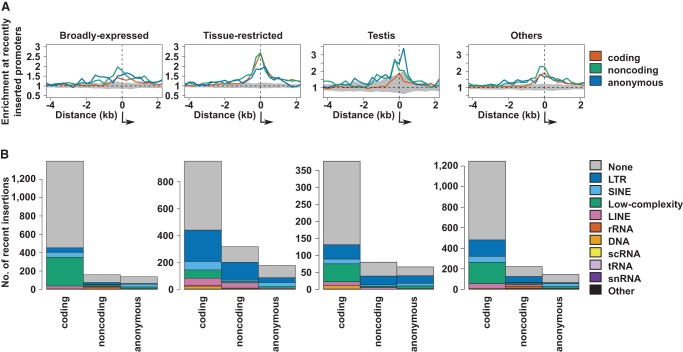
Promoter insertions frequently contain repetitive elements. (A) Enrichment of repetitive elements across recently inserted human promoters relative to the genome-wide expectation for insertions across promoter classes and expression profiles. The 95% confidence interval for genome permuted intervals is shown in gray, and the direction of transcription is shown by the arrows. The numbers of promoters which contribute to each enrichment are shown in the corresponding histograms in B. (B) Frequency of repetitive element families across recently inserted human promoters of the expression profiles, as in A.